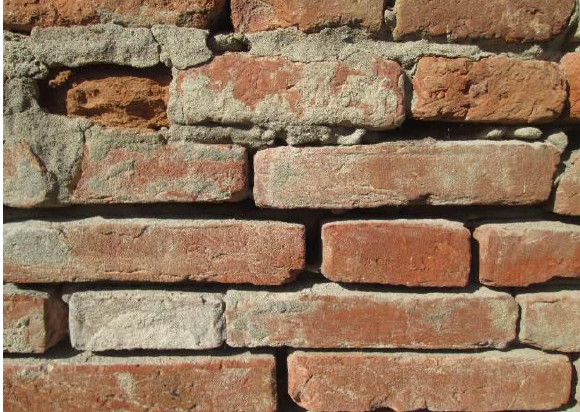
Figure 7: Loss of the